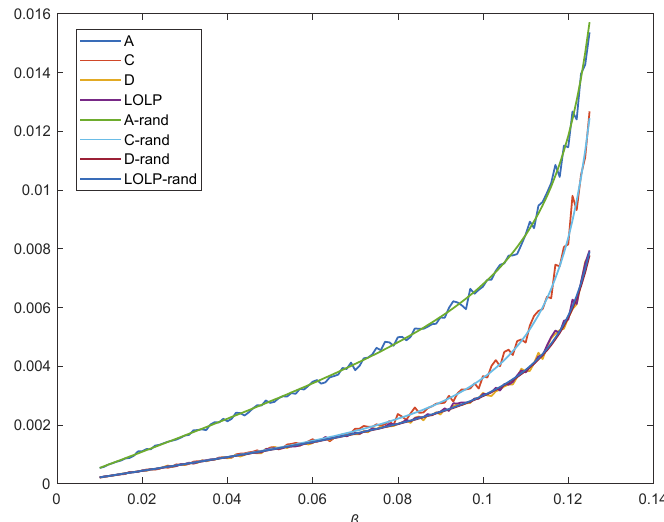
Figure 6. The failure probability as the increase in 𝛽